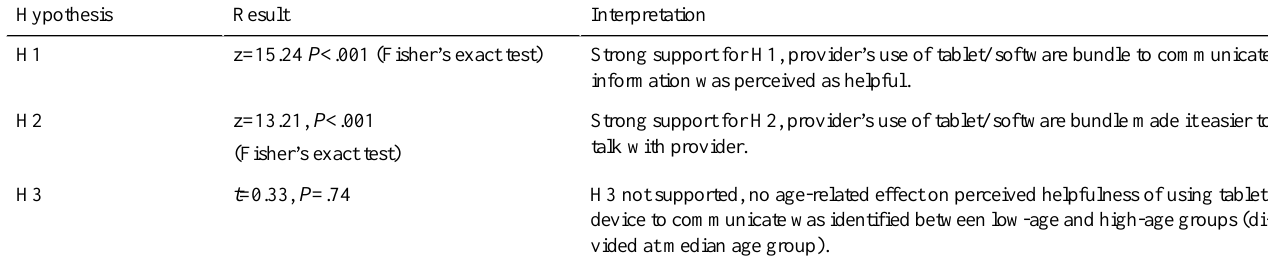
Table 4. Evaluation of